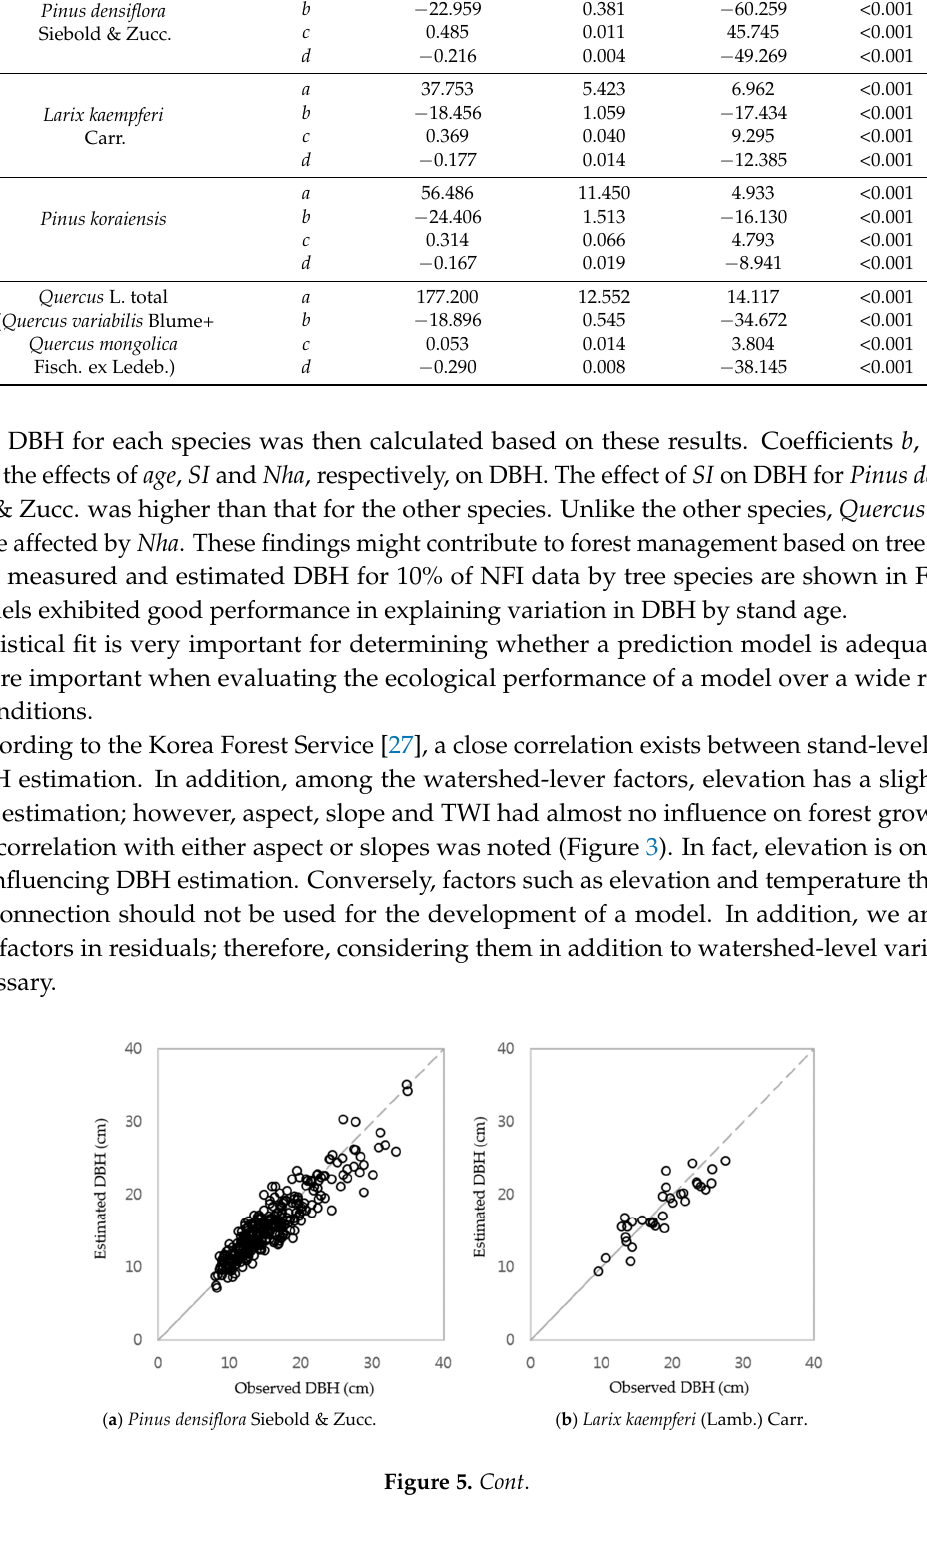
Table 4. Coefficient and significance level for the major tree species estimated from Equation (3). Tree Species Parameter Estimate Std. Error t -Value p -Value a 43.896 Pinus densiflora Siebold & Zucc.